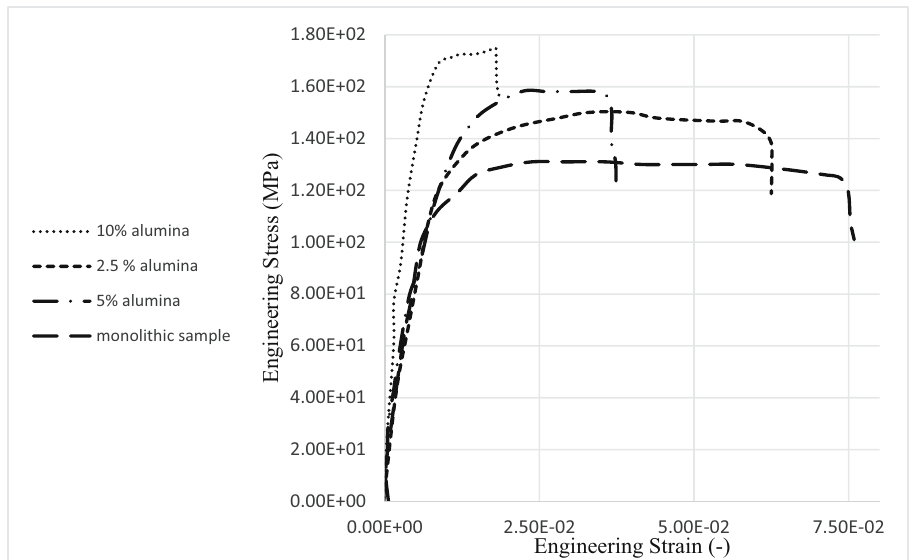
Figure 6: Engineering stress – strain curves of ARB - processed